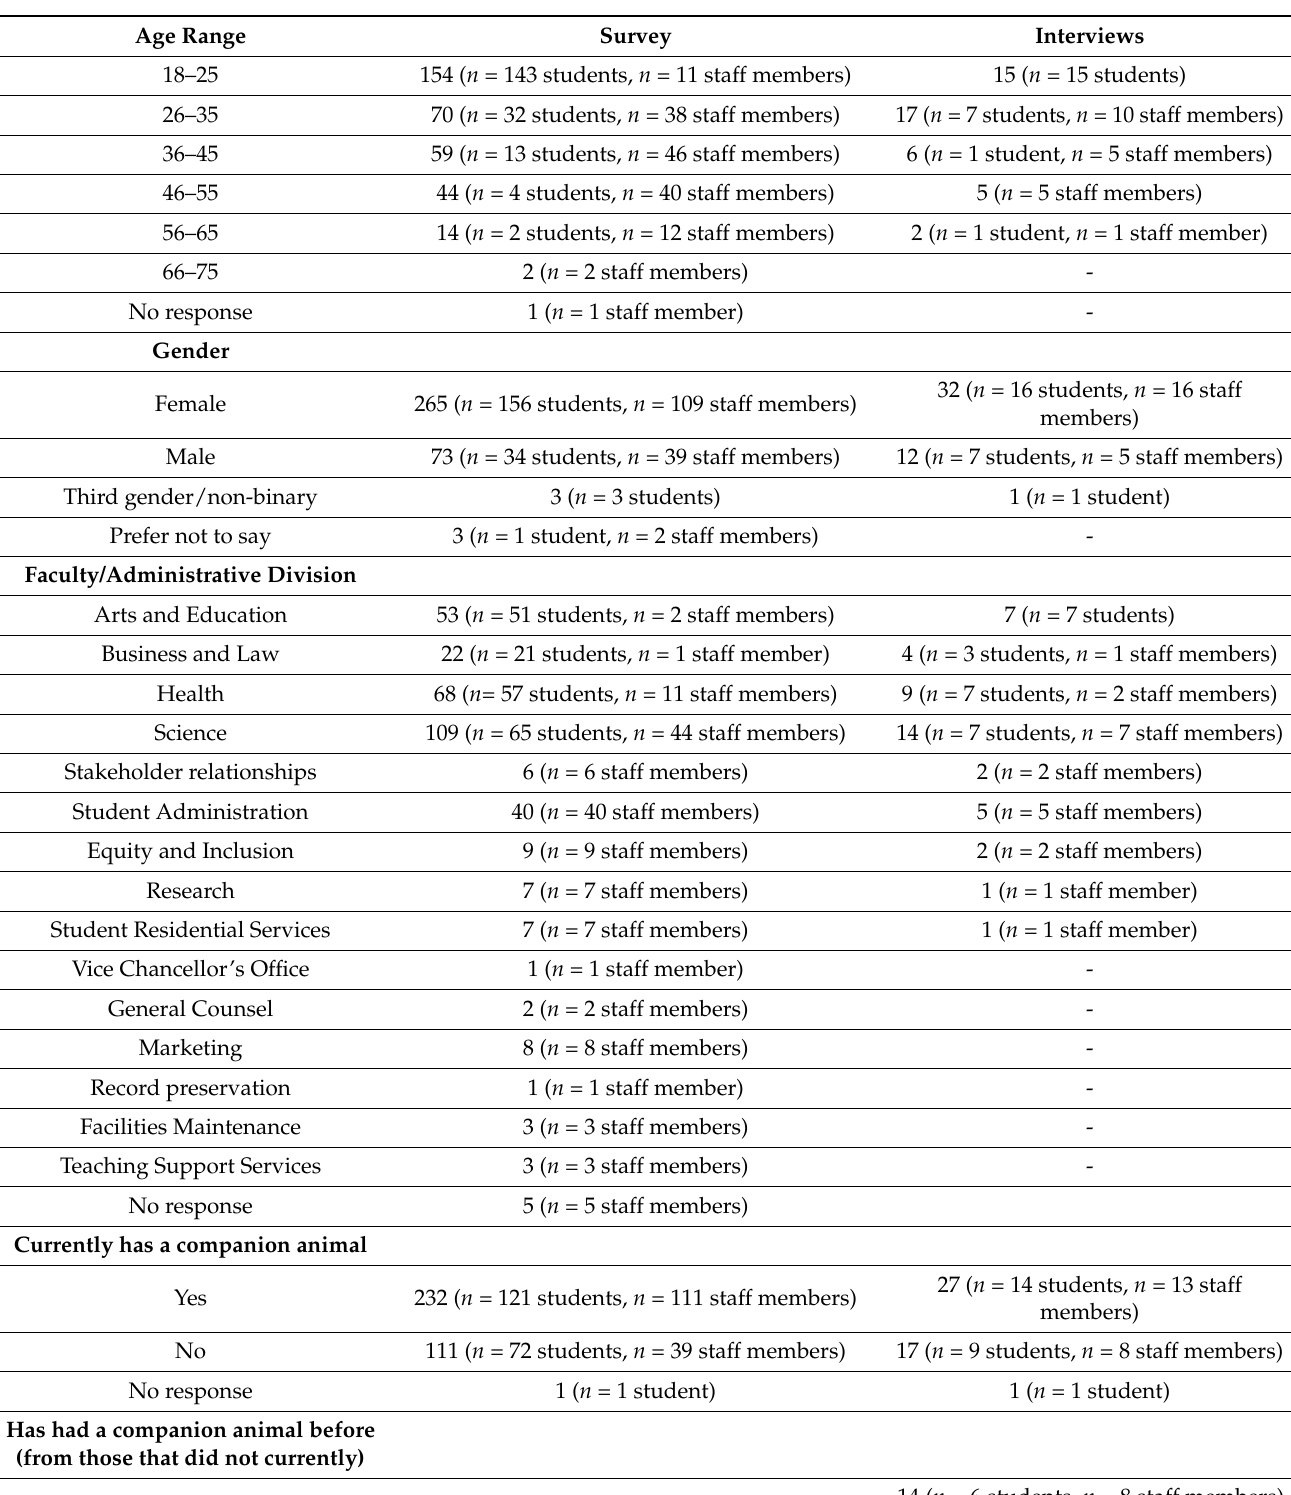
Table 1. Demographic data of